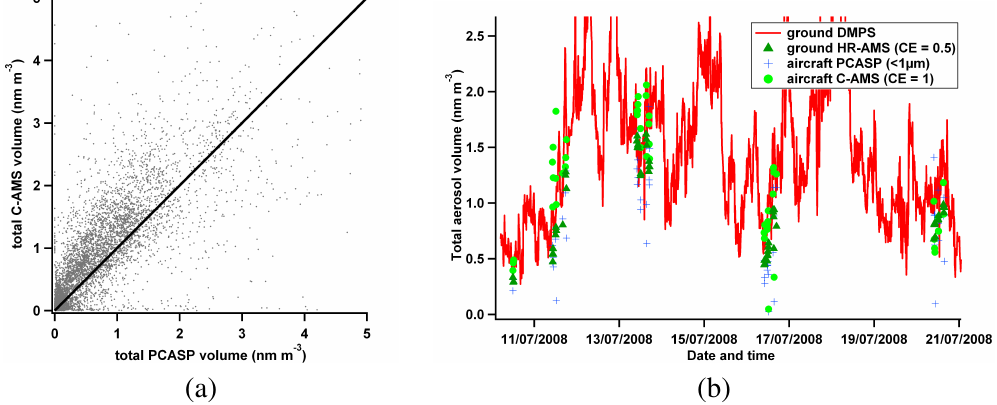
Fig. 2. (a) Total sub-micron aerosol volume measured by the C-AMS vs. the PCASP. Plot using all available data from the BAe-146. 1 : 1 line shown in black. (b) Comparison of total sub-micron aerosol volume measured from the ground site (DMPS and HR-AMS) and BAe-146 (PCASP and C-AMS) during ground site fly-bys. Conversion of AMS particulate mass to volume uses assumed organic and inorganic densities (Cross et al., 2007). Data shown with BAe-146 C-AMS CE = 1 and ground HR-AMS CE = 0.5.